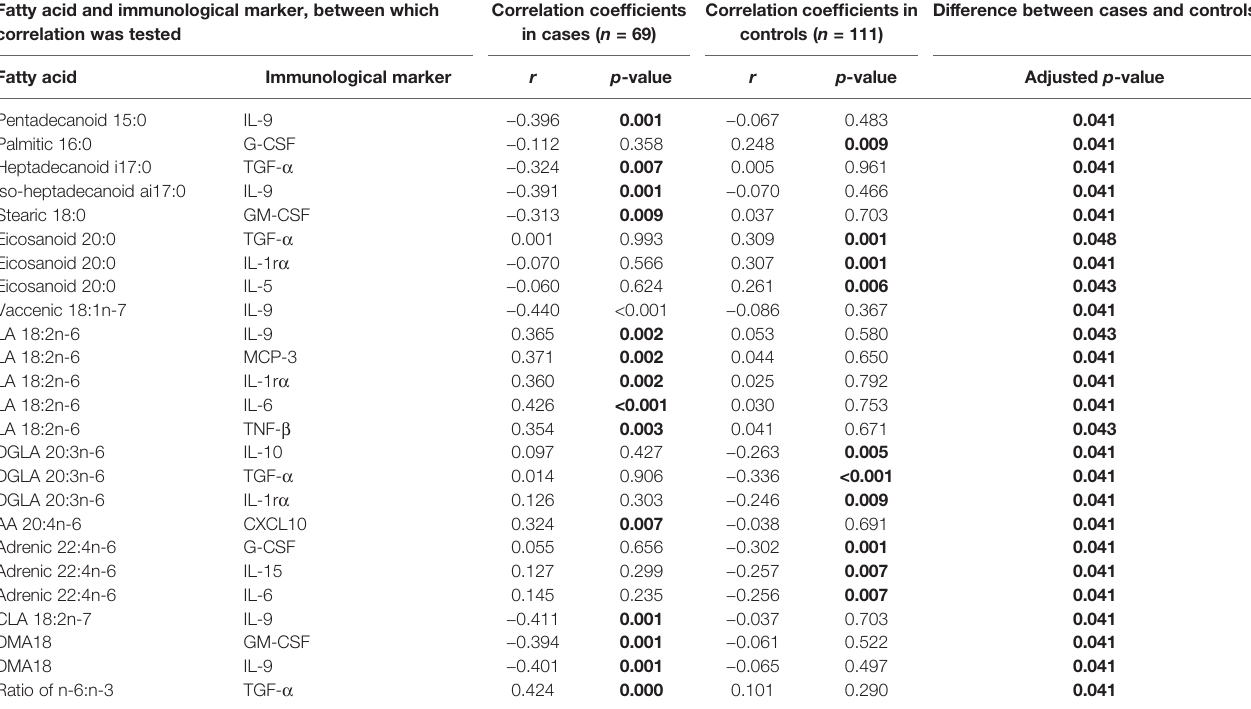
TABLE 3 | Differences in Spearman correlation coef fi cients between serum fatty acids and immunological markers at 6 months of age by case – control status. Fatty acid and immunological marker, between which correlation was